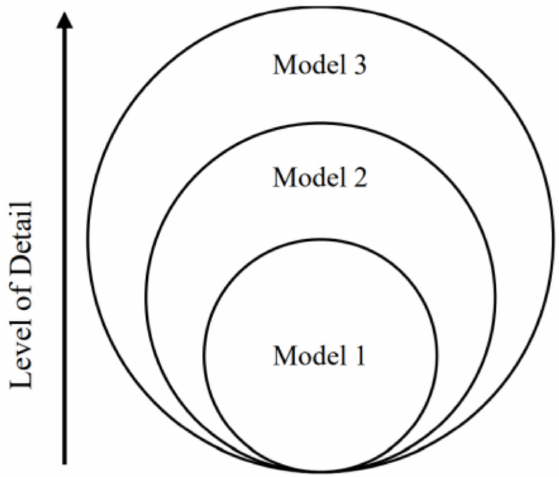
Figure 8. Hierarchical structure of developed models.